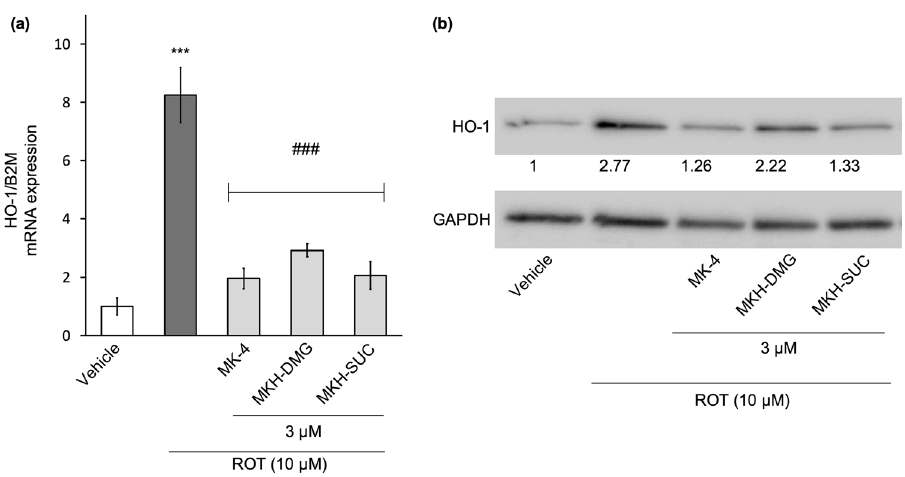
Figure 6. Influence of MK-4 and MKH derivatives on HO-1 induced by ROT. The NIH/3T3 cells were treated with 3 µM MK-4, MKH-DMG, or MKH-SUC for 6 h in the presence of 10 µM ROT. ( a ) HO-1 mRNA level obtained by qPCR. ( b ) HO-1 protein was detected by western blotting. ***p < 0.001 versus vehicle group; ### p < 0.001 versus ROT only group (Tukey’s test). Data are presented as mean ± SD (n =